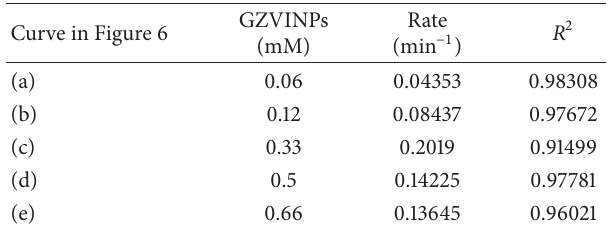
Table 1: Rates constants of degradation of bromothymol blue